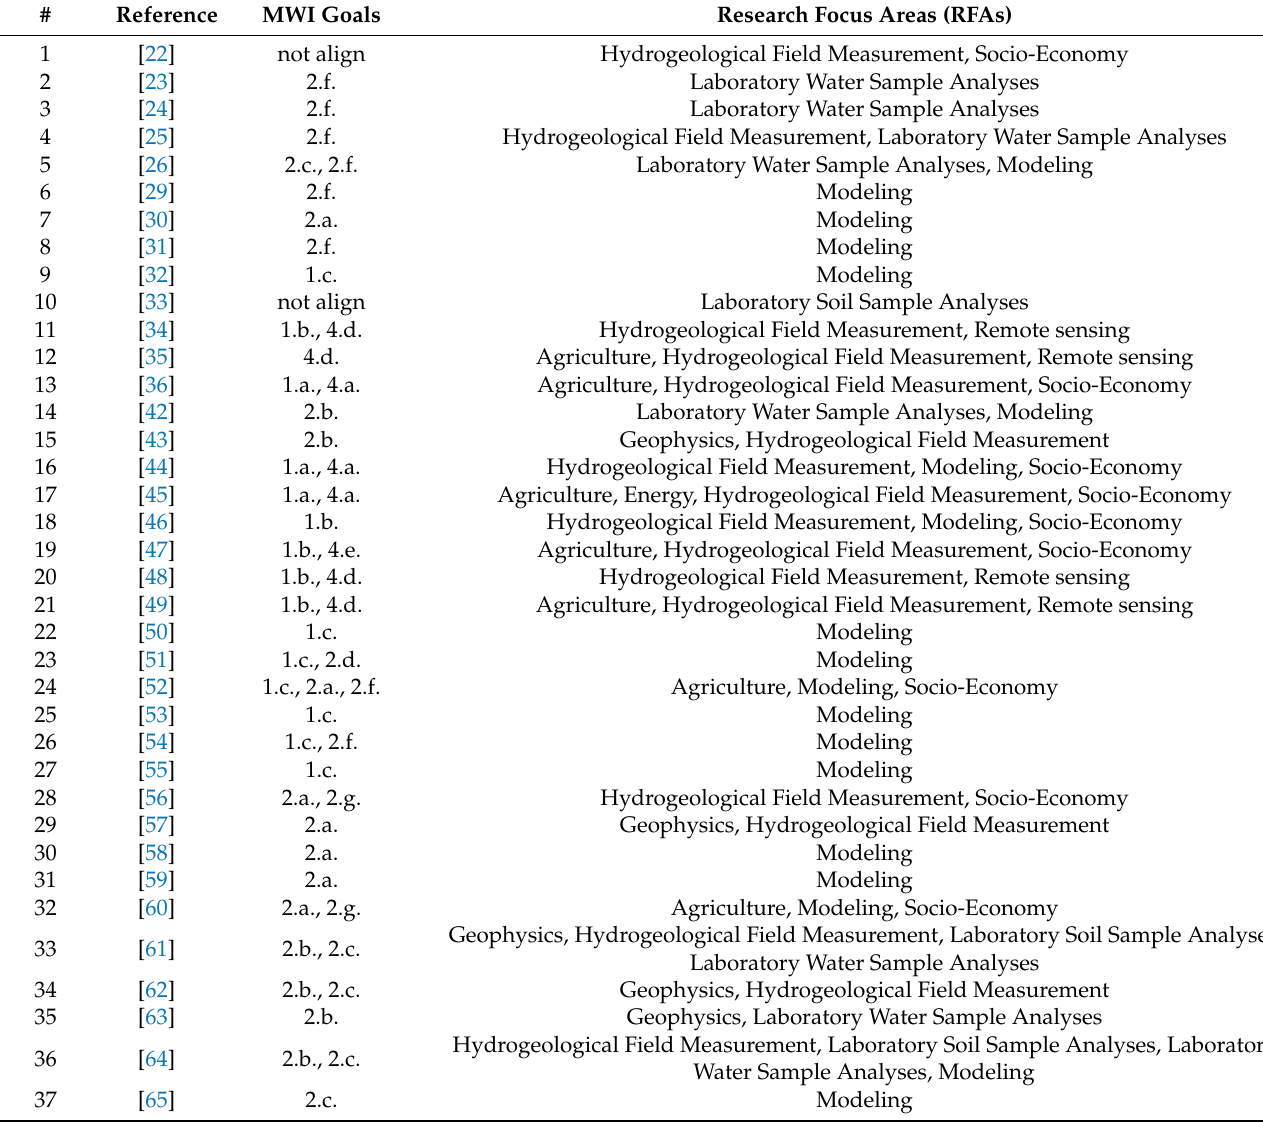
Table A1. List of the analyzed documents, goals, and